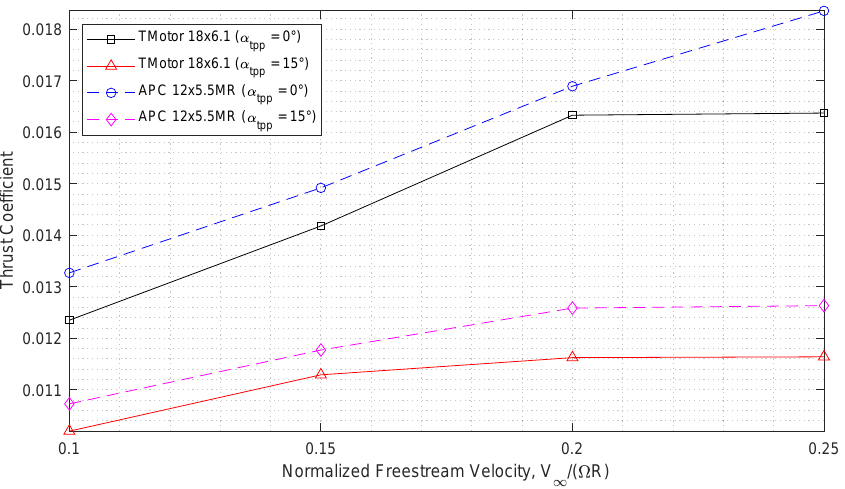
Figure 11. Thrust coefficient vs. normalized freestream velocity as predicted with the DDE method.